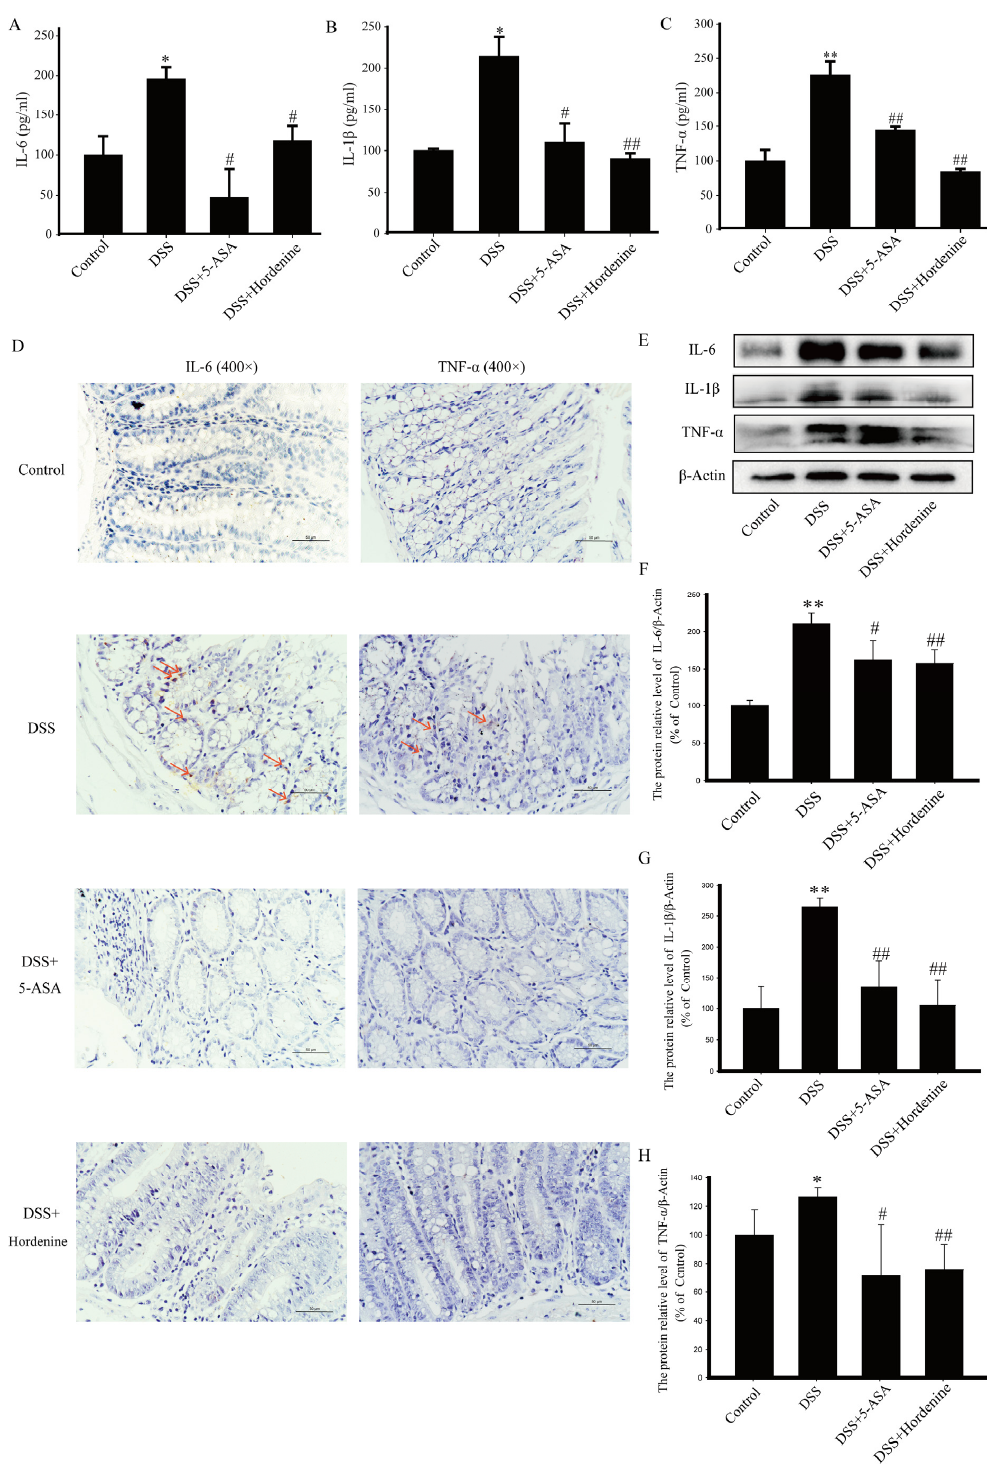
Figure 2. Hordenine (50 mg/kg) reduces levels of inflammatory mediators in the colon of mice with dextran sodium sulfate (DSS)-induced colitis. Enzyme-linked immunosorbent analysis of IL-6 ( A ), IL-1 β ( B ) and TNF- α ( C ) in colon tissue supernatants. * p < 0.05, ** p < 0.01 vs. control group; # p < 0.05, ## p < 0.01 vs. DSS group. ( D ) Immunohistochemical staining of IL-6 and TNF- α in colon tissues.Red arrows point to the positive expression of the target protein, scale bar: 50 µ m. ( E – H ) Western blotting analysis of IL-6, IL-1 β and TNF- α expression in colon tissues. * p < 0.05, ** p < 0.01 vs. control group; # p < 0.05, ## p < 0.01 vs. DSS